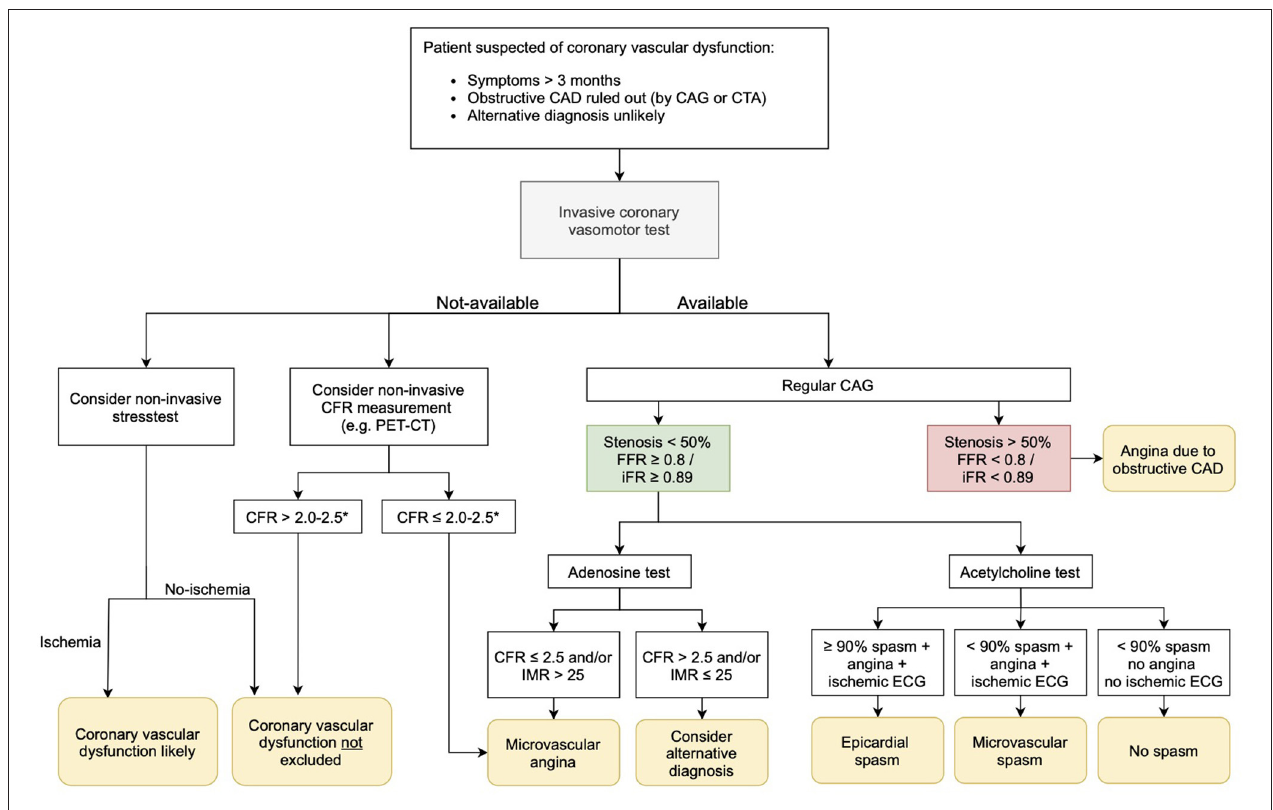
FIGURE 2 | Possible diagnostic